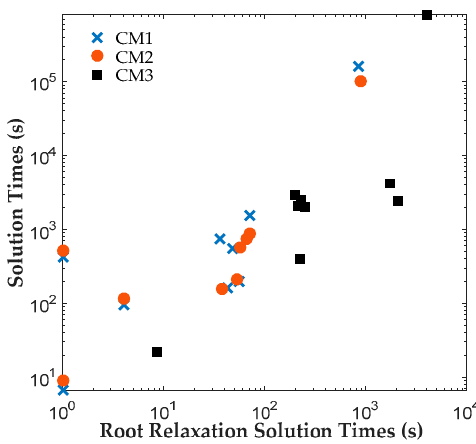
Figure 6. Change in solution times with root relaxation solution time for CM1, CM2 and CM3. The strong linear correlation is evident from this plot.